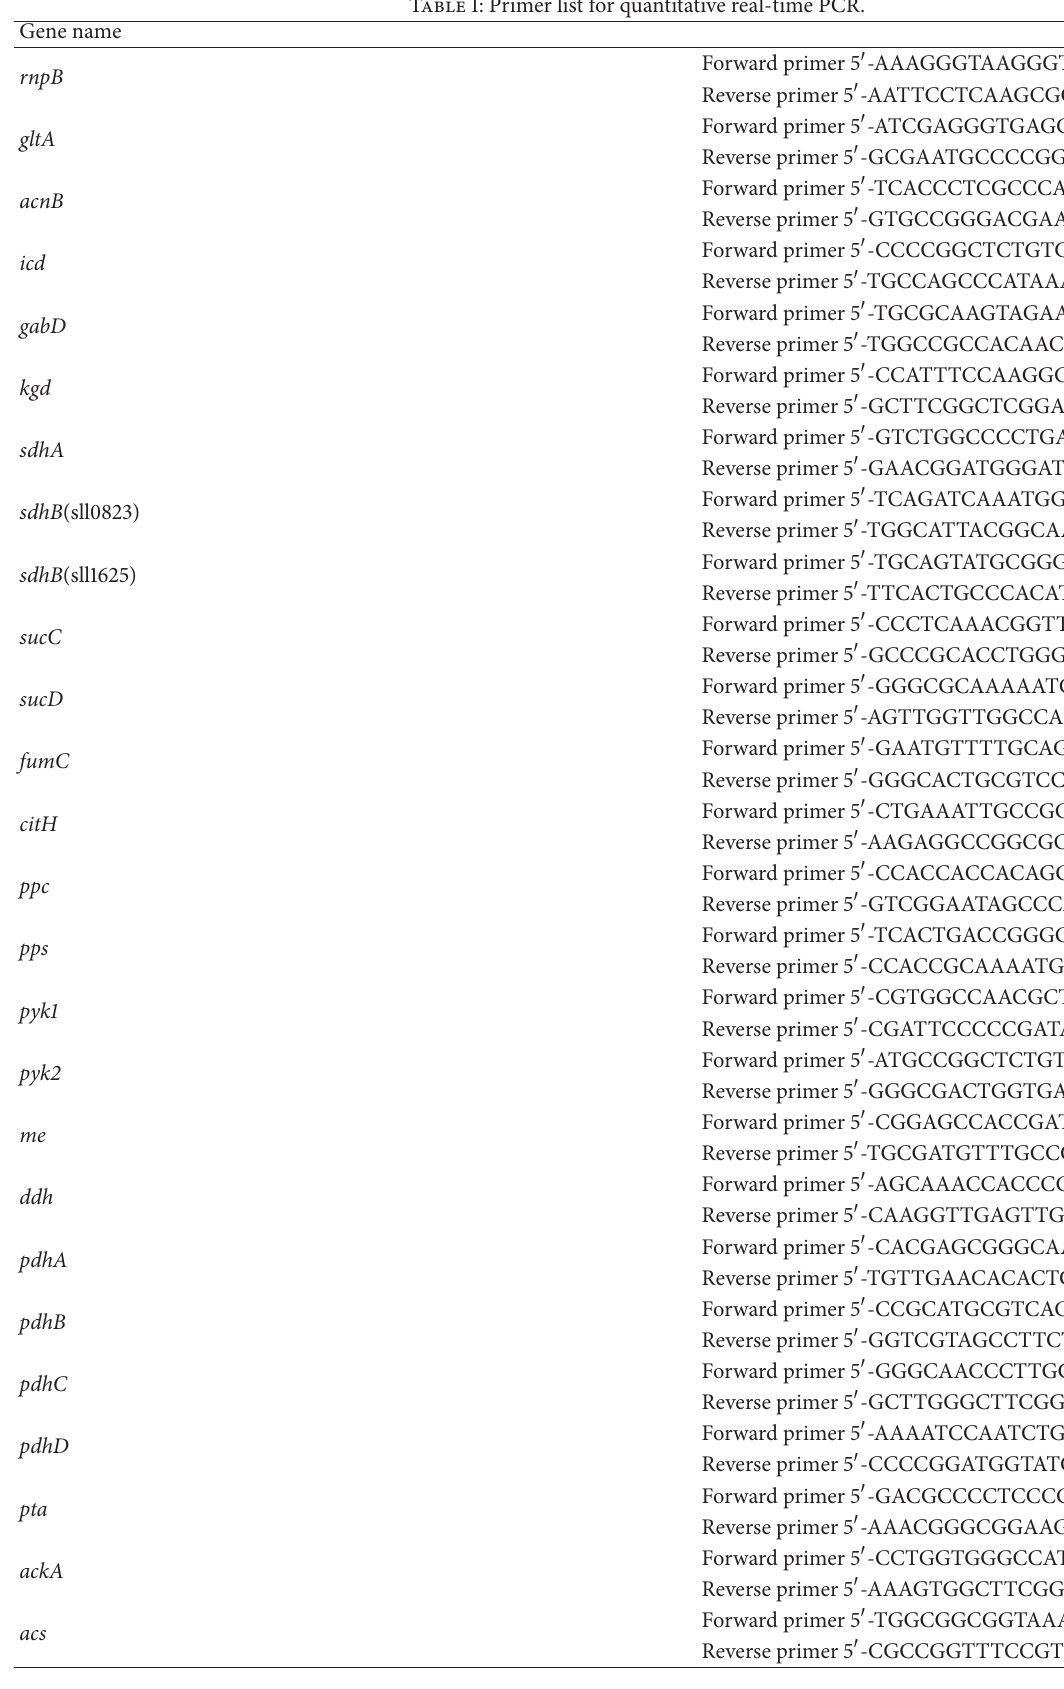
Table 1: Primer list for quantitative real-time